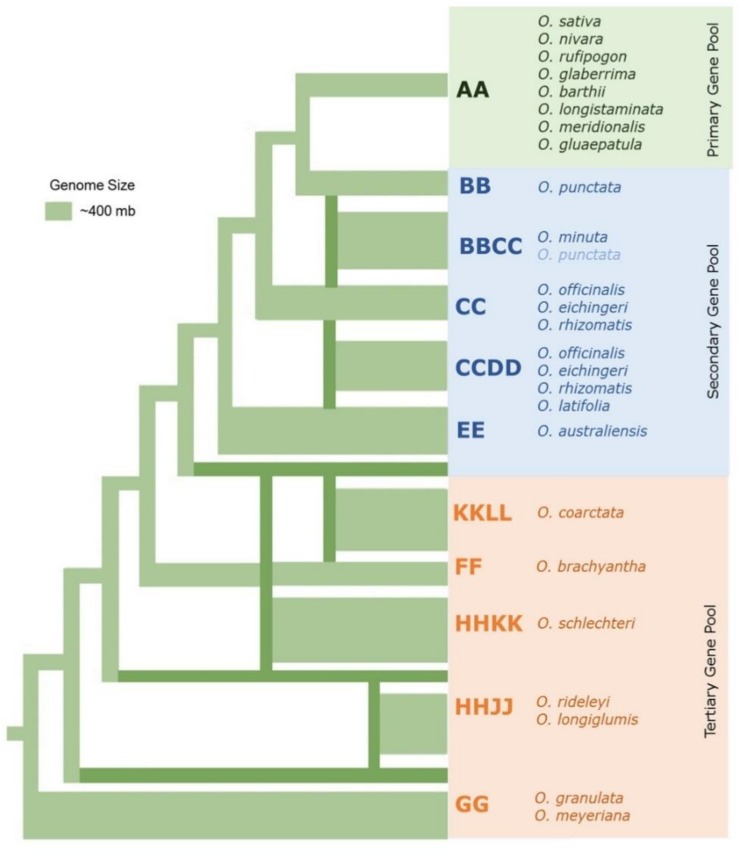
The phylogenetic relationships among the major wild rice species. Neighbor joining tree in which the thickness of the lines connecting to each lineage represents approximate genome size modified from Ge et al. (1999); Lu et al. (2009), and Ammiraju et al. (2010).